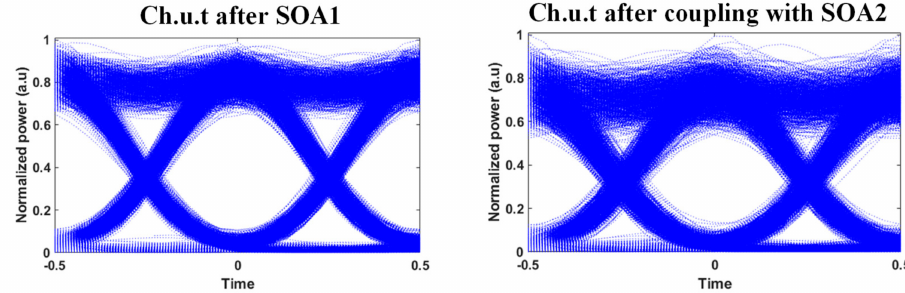
Figure 7. Simulated eye diagrams for a channel under test (Ch.u.t.) at SOA1 output ( left ) and after coupling with parallel SOA2 ( right ) for the case of 32 × 25 Gb / s